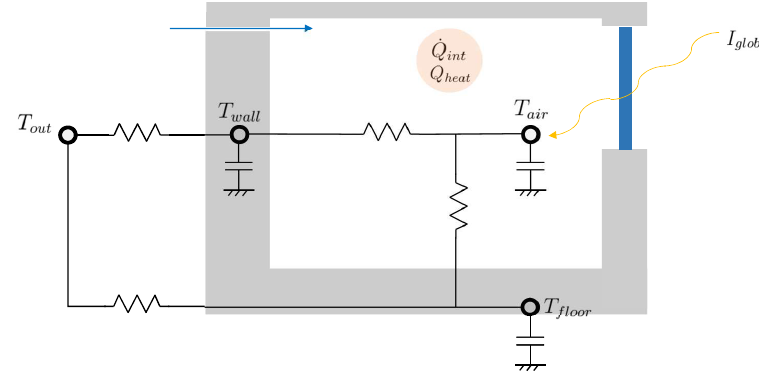
Figure 1. Space heating state space model